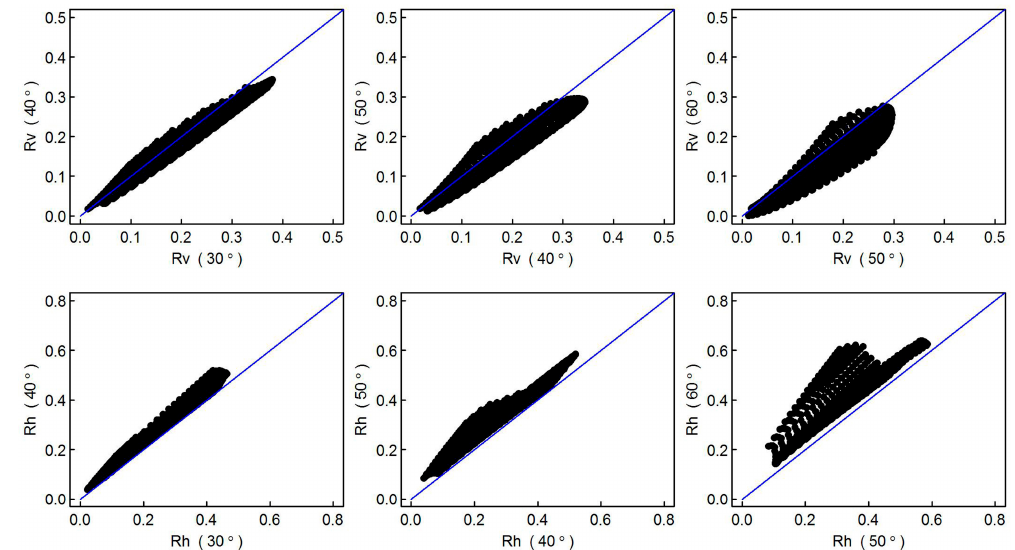
Figure 3. The incident angle dependence of the effective surface reflectivity from the AIEM simulated data. The two rows are for vertical and horizontally polarization, respectively ( Rv : reflectivity for vertical polarization; Rh : reflectivity for horizontal polarization).